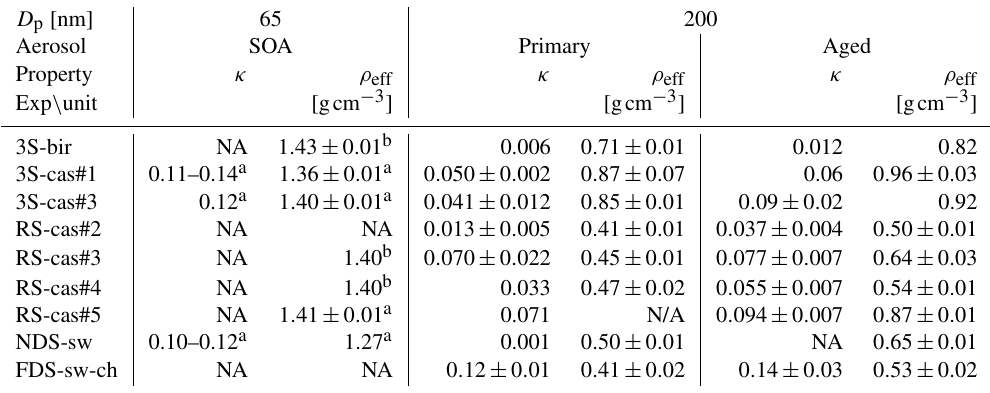
Table 5. CCN activity ( κ ) and effective density ( ρ eff ) of (cid:118) 65nm secondary particles and (cid:118) 200nm primary and photochemically aged particles. Inferred κ values for secondary-organic-aerosol-dominated particles are included for the three cases observed. The indicated ranges are ± 2 standard deviations for the 200nm primary particles when more than two data points are available, while they represent the full range observed for the photochemically aged particle parameters. D p